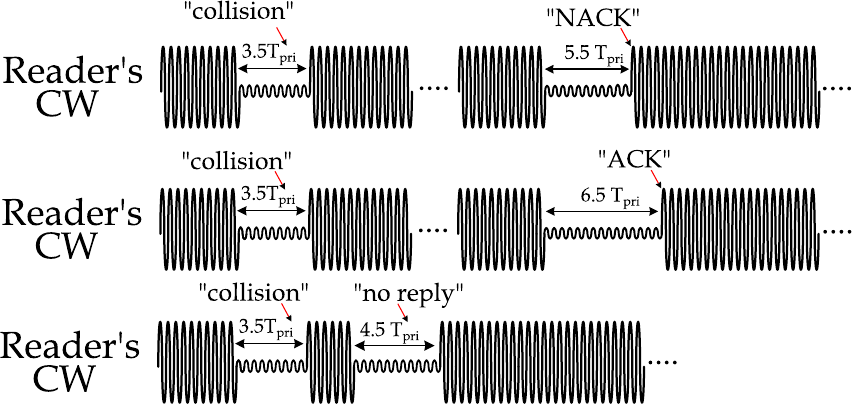
Figure 8. Three different scenarios of reader commands in anti-collision protocols with MCI process.